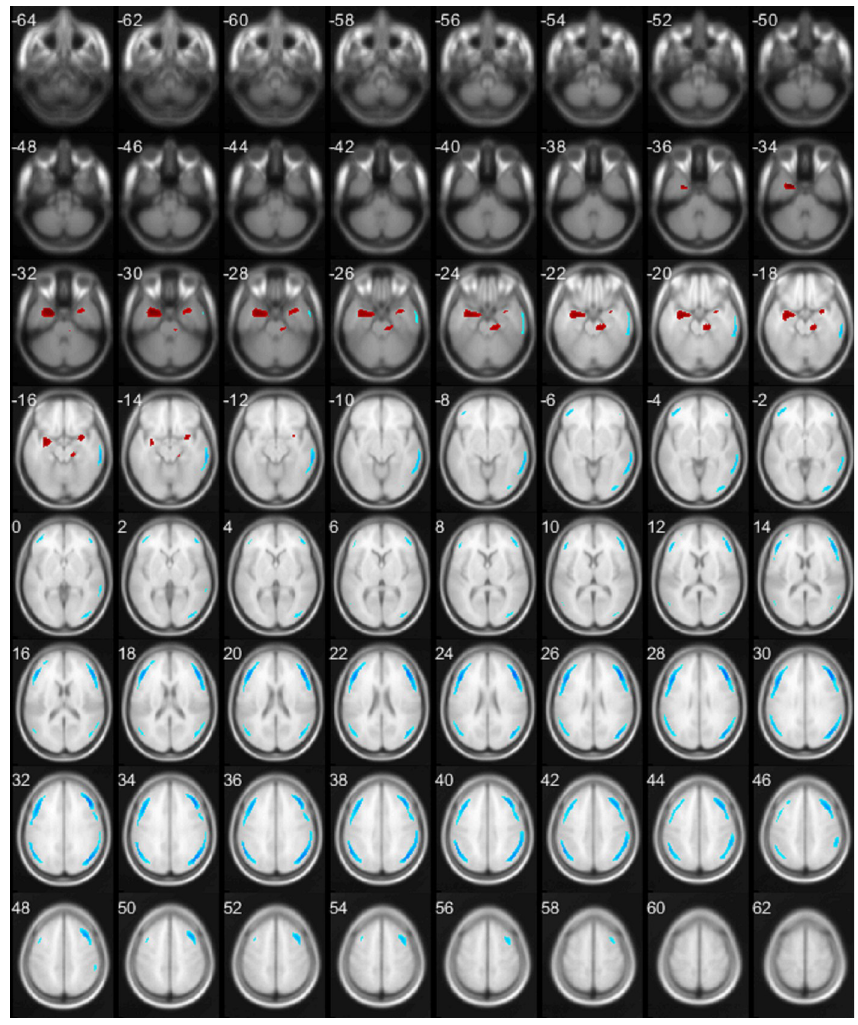
Fig 3. A map of significantly changed metabolic clusters in patients with major depression as compared to the control. Statistical parametric maps displayed on transverse sections depicting regions of hyper-metabolic (red) and hypo-metabolic (blue)